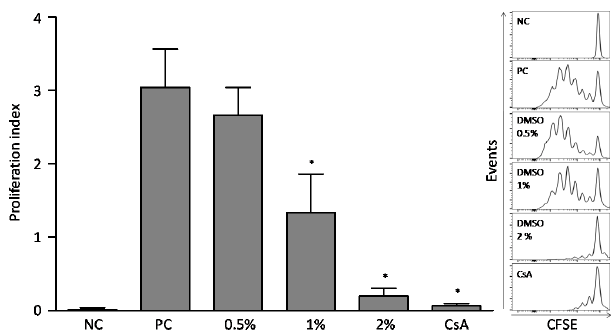
Figure 3. Dymethyl sulfoxide (DMSO) effect on lymphocyte proliferation using the 5-(and-6)-carboxy-